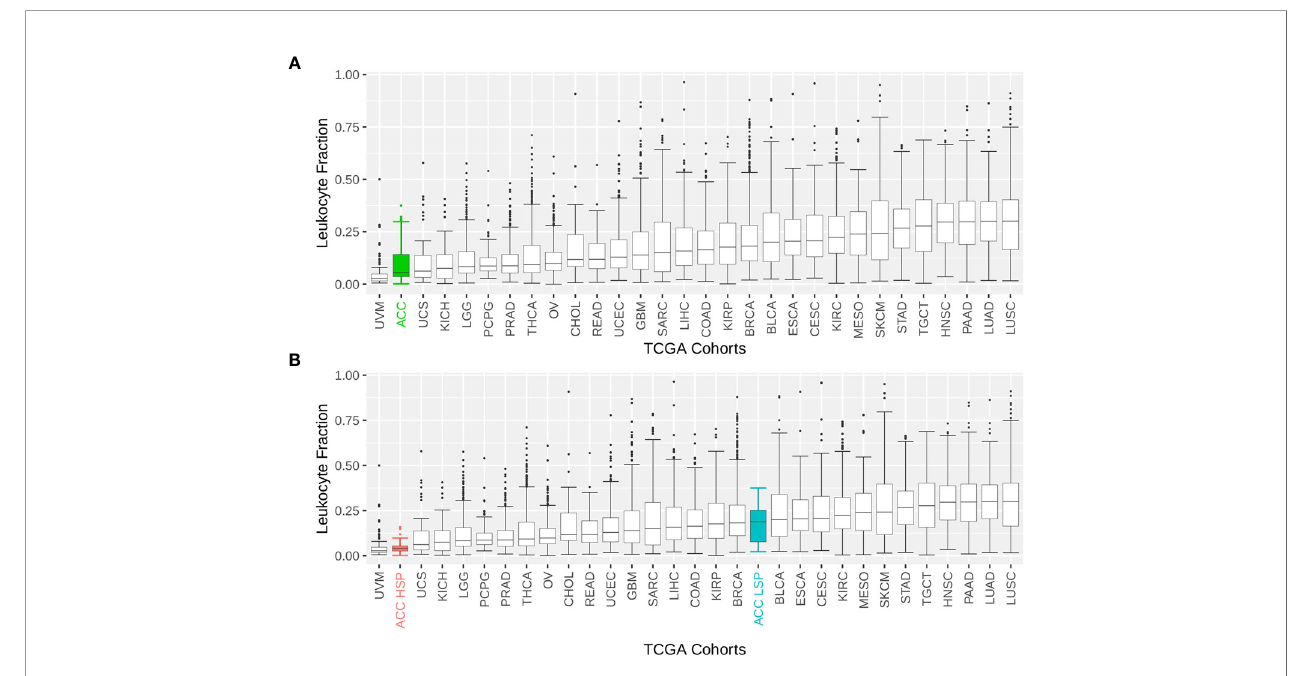
FIGURE 1 | Boxplot of the leukocyte fraction in the tumor microenvironment of 30 TCGA solid tumors. The leukocyte fraction was inferred by Thorsson et al. (11) for 10,448 participants included in The Cancer Genome Atlas (TCGA) database using molecular methods and compared with hematoxylin and eosin stained images, which demonstrated good correlation. Participants were grouped by TCGA cohort. The boxplot shows the median and interquartile range (IQR) for the leukocyte fraction of each cohort. Whiskers are set at 1.5 IQR and outliers (above and below the 1.5 IQR) are presented as points. TCGA cohorts were ordered by median values. (A) Patients with adrenocortical carcinoma (ACC) are represented as one group. (B) Patients with ACC are divided according to steroid